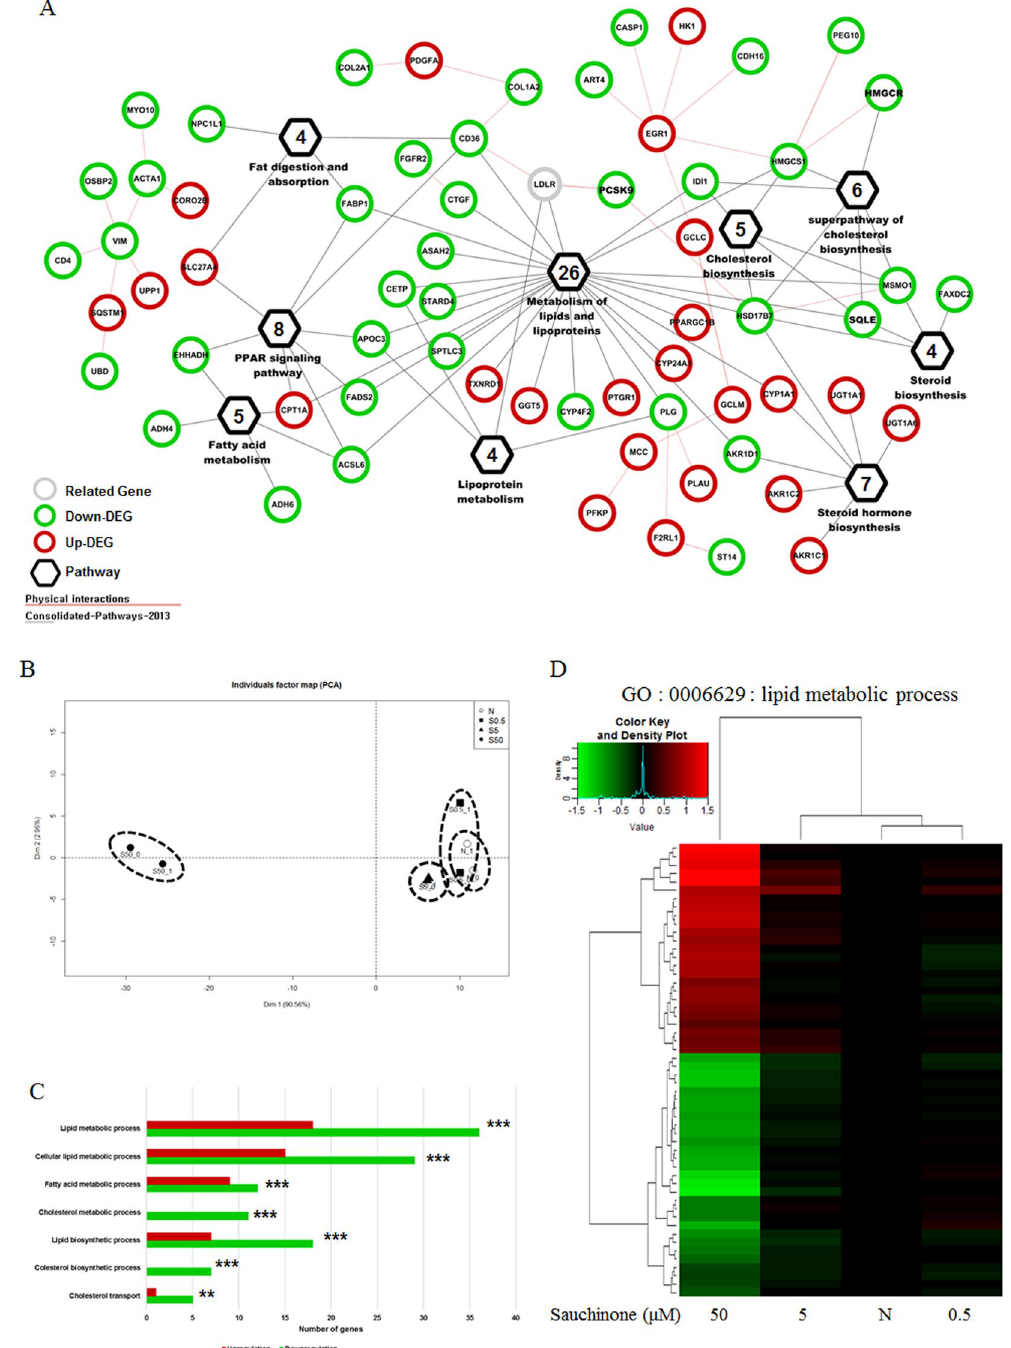
Figure 1. Metabolic gene profiling of HepG2 cells treated with sauchinone for 24 hours. ( A ) The protein- protein interaction network for the 280 DEGs was analyzed with GeneMANIA (ver. 3.4.1) performed with the Cytoscape plugin of the Cytoscape (ver. 3.5.1, http://www.cytoscape.org/) network visualization and analysis environment. ‘Physical interaction’ was chosen with the default options, and the ‘2013 consolidated-pathway’ option was selected to find associations among the 281 DEGs. ( B ) We used R (ver. 3.3.2) for all statistical analysis (https://cran.r-project.org/). The ‘factoMineR’ (http://factominer.free.fr) and ‘rgl’ (https://r-forge.r-project.org/ projects/rgl/) packages were used for principal component analysis (PCA) and visualization. ( C ) Enrichment of KEGG pathways in the metabolic gene profiling analysis was determined using the DAVID software. Benjamini- Hochberg adjusted p values are shown for each indicated bar ( *** p < 0.0001, ** p < 0.05, * p < 0.1). ( D ) Hierarchical clustering of all metabolic genes regulated by acRoots in LM3 cells. The genes are annotated to the term “metabolic process” (GO: 0008152) or its children in Gene